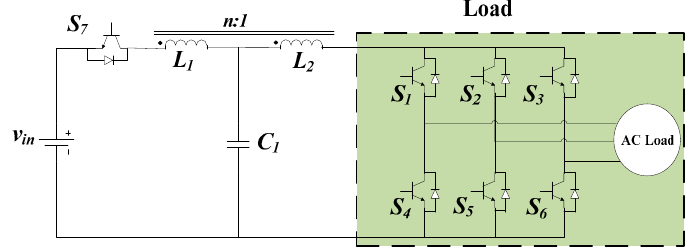
Figure 5. Bidirectional Trans-Z-source inverter topology.